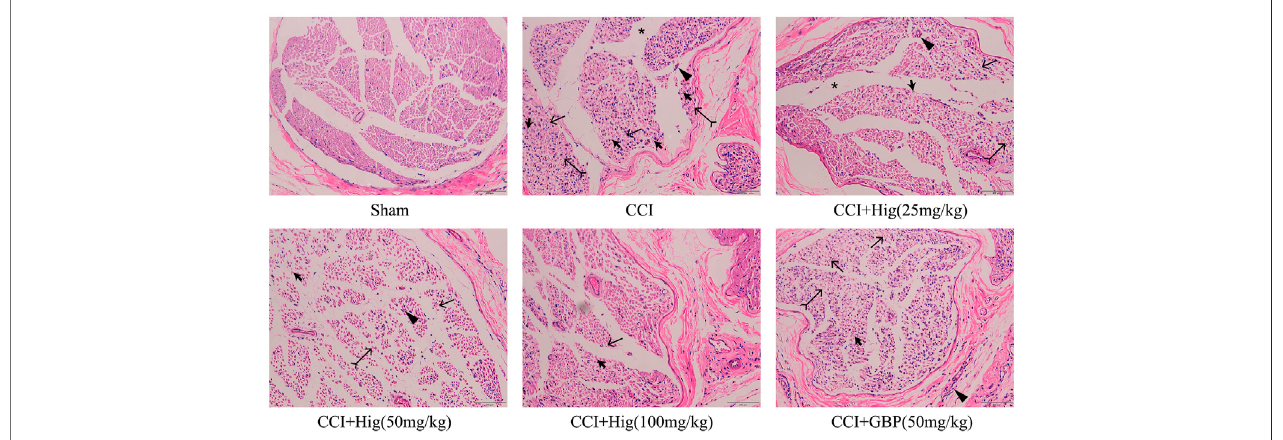
FIGURE 6 | The typical pathological images of DRG tissue in CCI rats. Thick arrow, thin arrow, bi fi d arrow, triangle arrow, and star symbols illustrate Schwann cell (SC) nuclei, myelin vacuolation, changes of axoplasm, in fl ammatory cell in fi ltration, and wide separation between the nerve fi bers, respectively. Scar bar (cid:2) 200 µm.